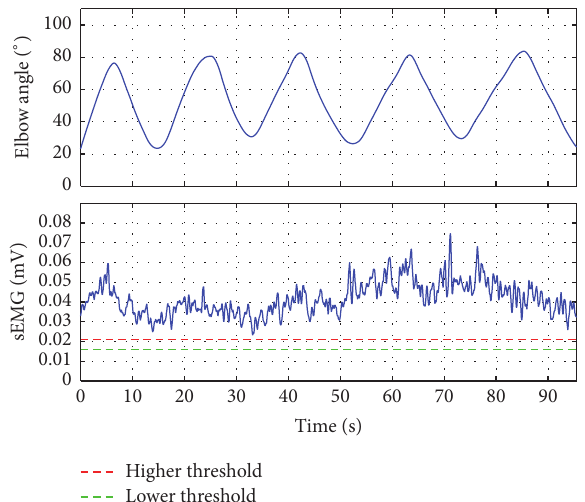
Figure 11: Plots for the lifting task without the assistive device